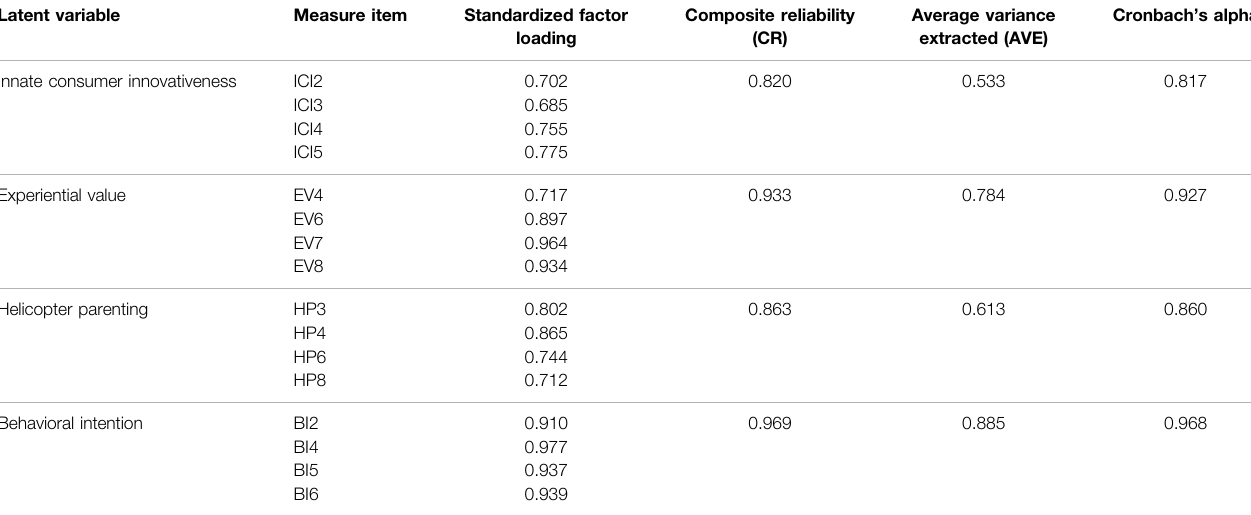
TABLE 3 | Results of con fi rmatory factor